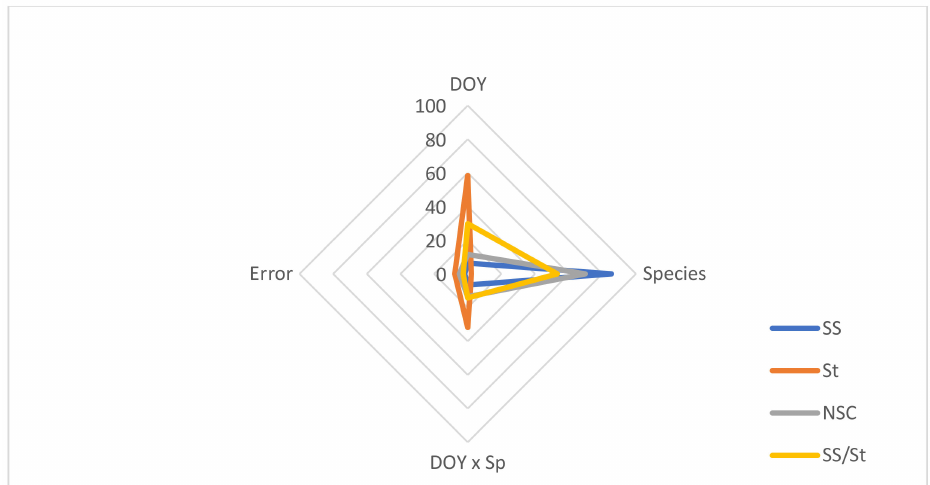
Figure 5. Proportion of the total variance in soluble sugars (SS), starch (St), non-structural carbohy- drates (NSC), and soluble sugars/starch ratio (SS/St) by sources of variation (DOY, Species, DOY × Sp, and